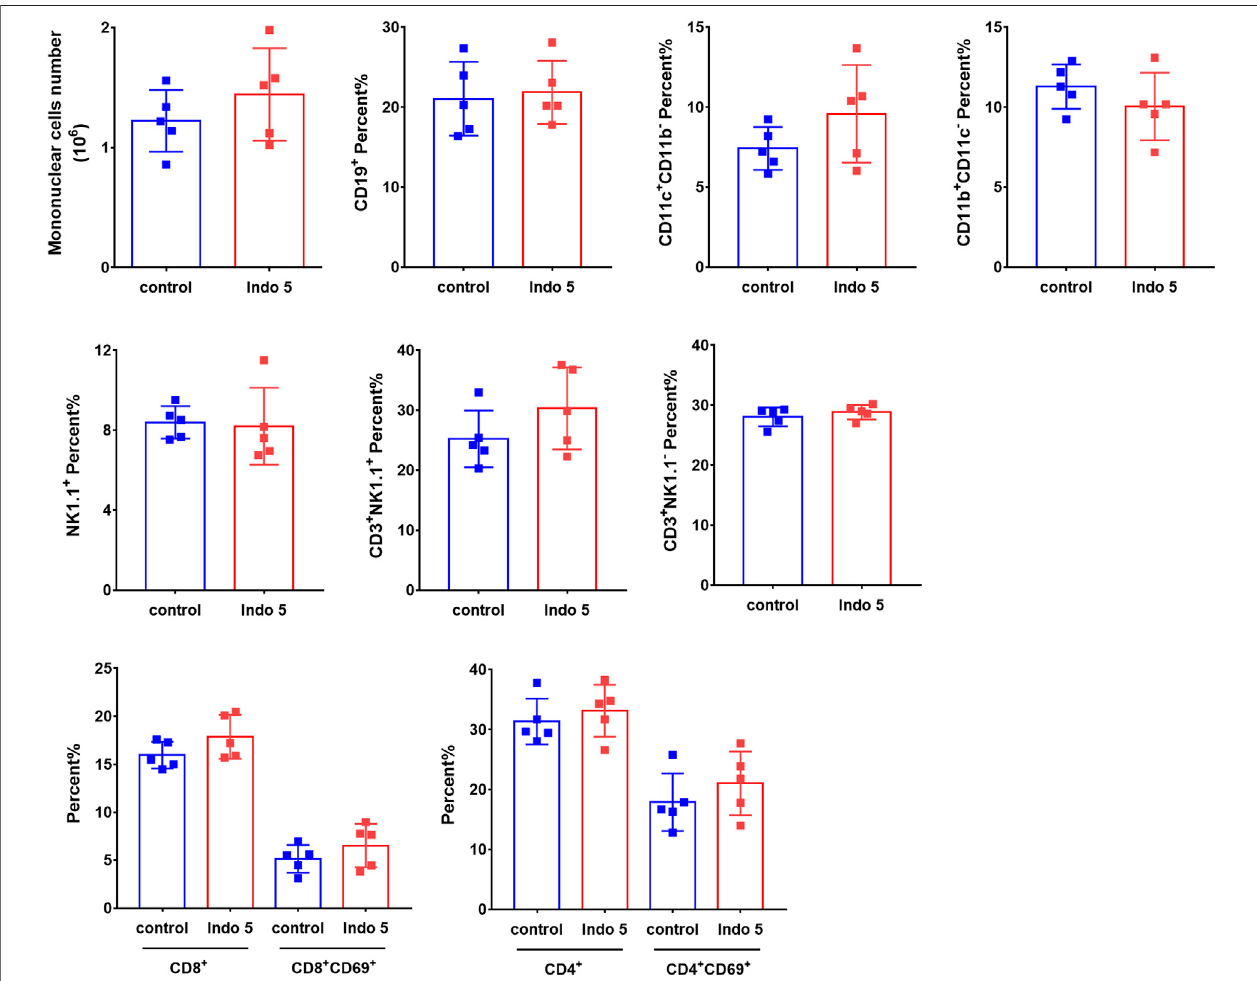
FIGURE7| EffectsofcontinuousadministrationofIndo5for21 daysonthenumberandconstitutionofimmunecellsintheliver.Themicewereorallyadministered withIndo5(60 mg/kg,oncedaily)for21 days( n (cid:2) 6).Onday21,theywerekilled,andhepaticmononuclearcellswereisolated.Thenumberoflivermononuclearcellsand frequencies of T cells (CD3 + NK1.1 − ), NK cells (CD3 − NK1.1 + ), NKT cells (CD3 + NK1.1 + ), B cells (CD19 + ), DCs (CD11c + CD11b − ), myeloid cells (CD11b + CD11c − ), T-cell subsets (CD4 + , CD8 + ), and activated T cells (CD4 + CD69 + , CD8 + CD69 + ) were measured using fl ow cytometry. Data are presented as the mean ± SD. Two-tailed t tests were performed. All p values were greater than 0.05. There was no statistical signi fi cance in the number or frequencies of immune cells in the liver between the administration group and the control